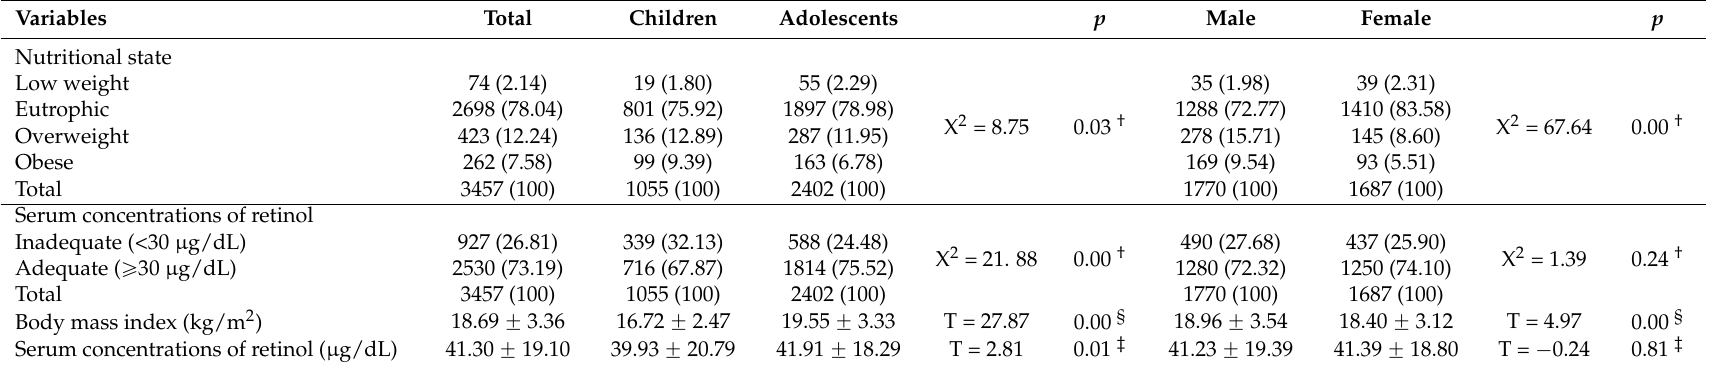
Table 1. Characteristics of children and adolescents according to age range and gender * .